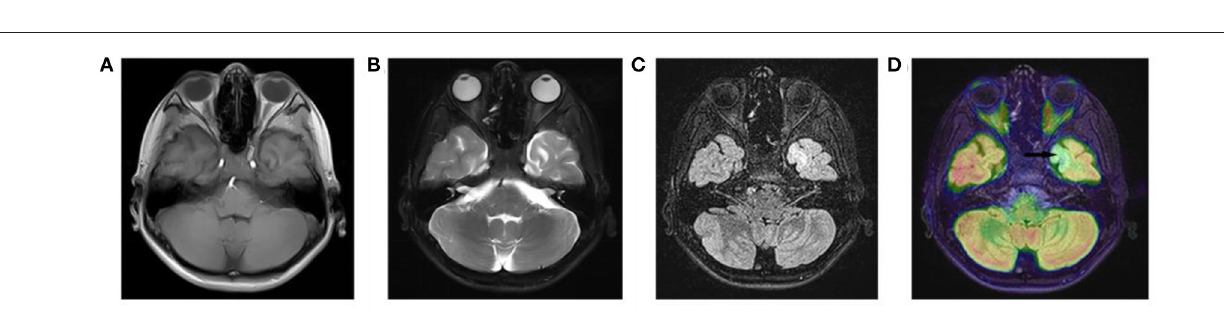
FIGURE 2 | The Cranial MRI and PET-MR image fusion of case 1. There are (A) mixed T1WI signals, (B) long T2WI signals and (C) long T2-FLAIR signals in the left temporal lobe. (D) PET-MR image fusion shows decreased metabolism (arrow) in the corresponding positions.